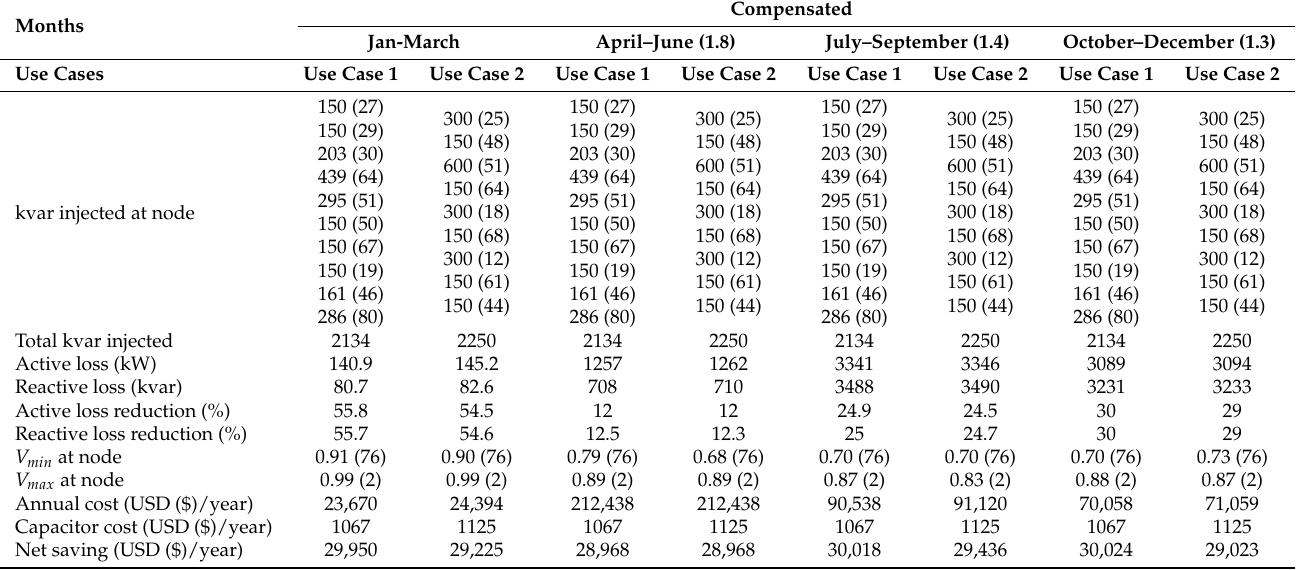
Table 8. Results comparison of N 2 for CS 2 (Scenario